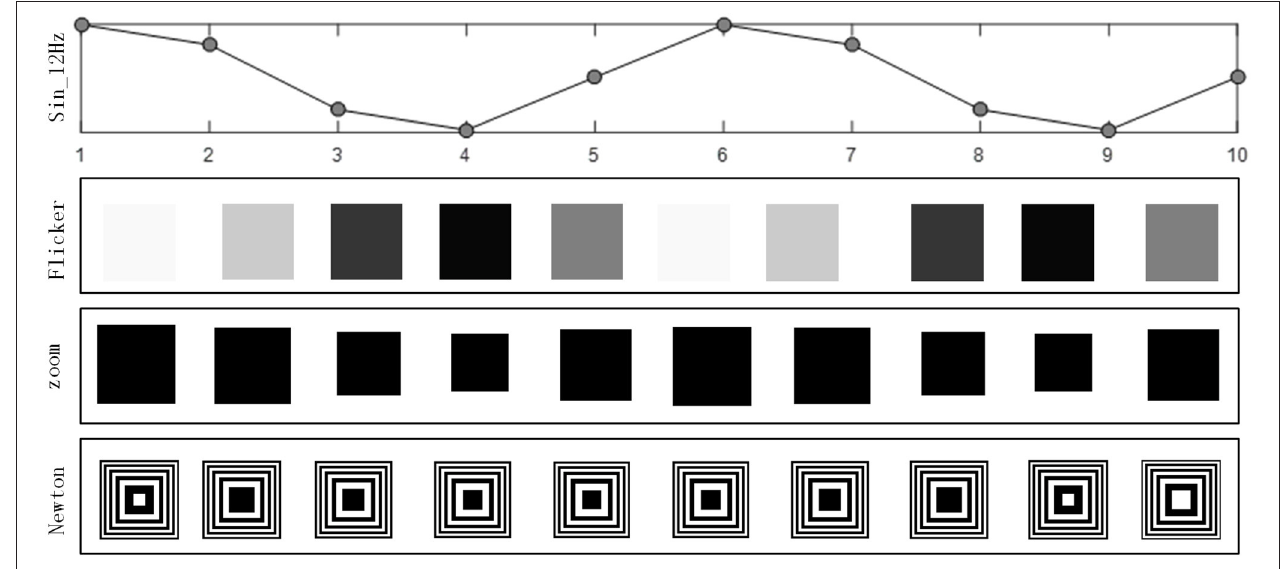
FIGURE 1 | Each frame of the 12Hz stimulation for different